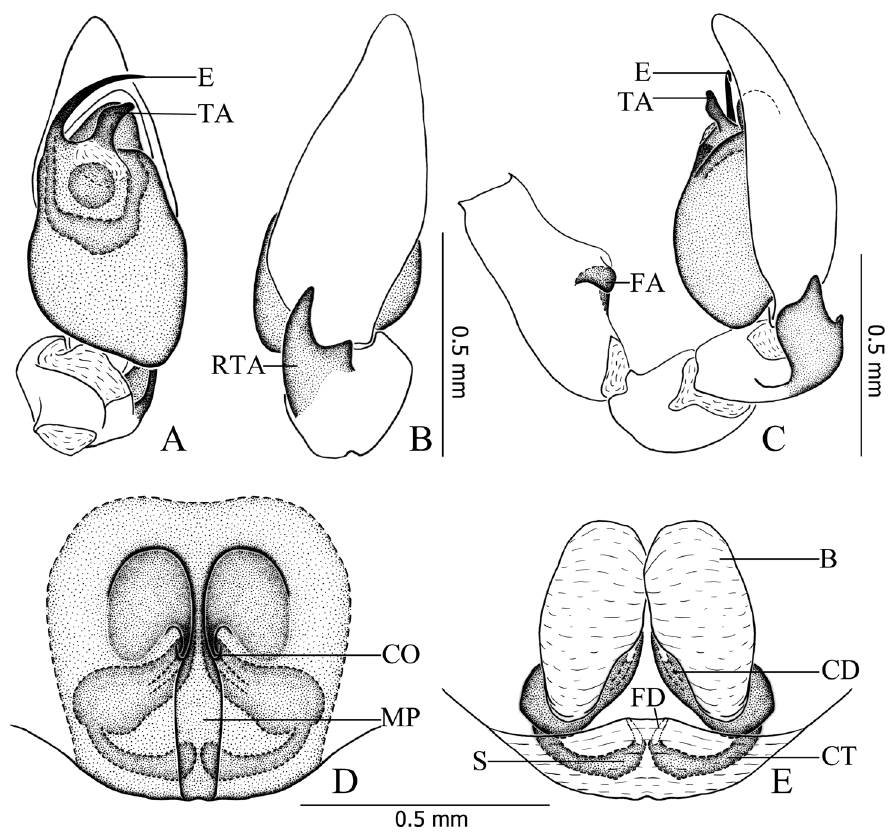
Figure 6. Otacilia yangmingensis sp. n. A left male palp, ventral view B same, dorsal view C same, retro- lateral view D epigyne, ventral view E vulva, dorsal view. Scale bars equal for A and B , equal for D and E